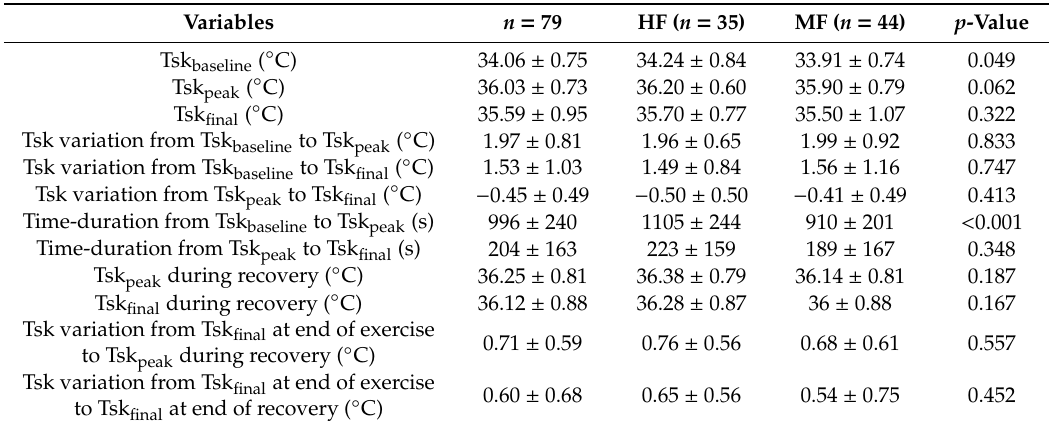
Table 2. Skin temperature response in an incremental exercise test until volitional exhaustion in high and moderately fit endurance